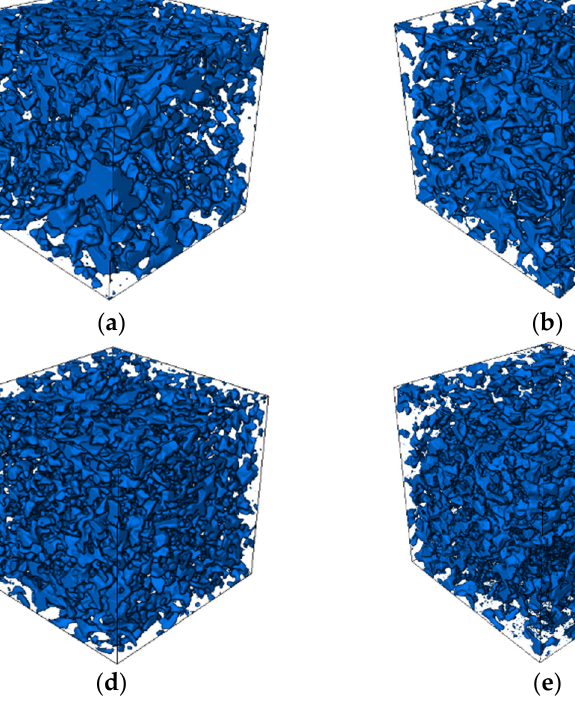
Figure 16. The 3D images of the specimens with different levels of content of basalt fiber: ( a ) 0 kg/m 3 ,